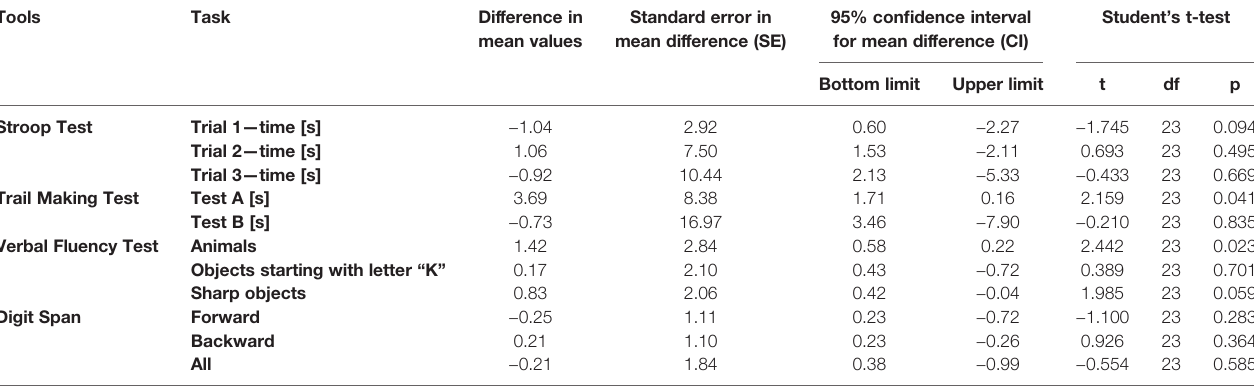
TABLE 5 | Comparison of results of cognitive function measurement 3 months after the fi rst measurement in patients with schizophrenia without metabolic syndrome.